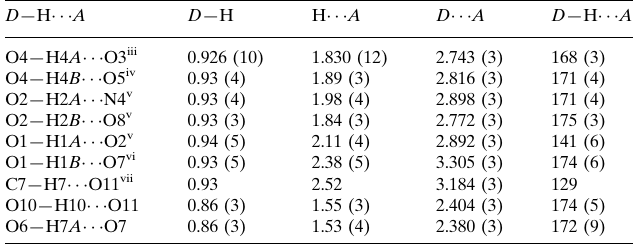
Hydrogen-bond geometry (A˚ , (cid:2)